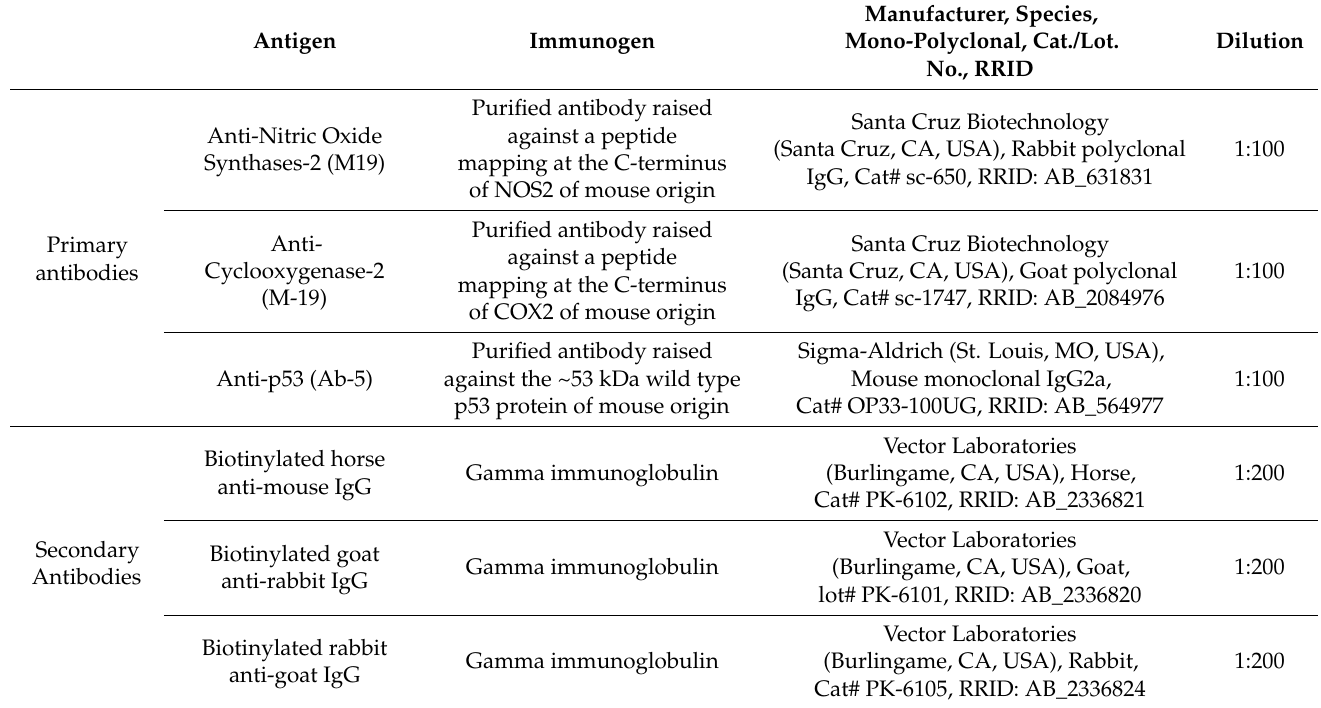
Table 2. Primary and secondary antibodies used for